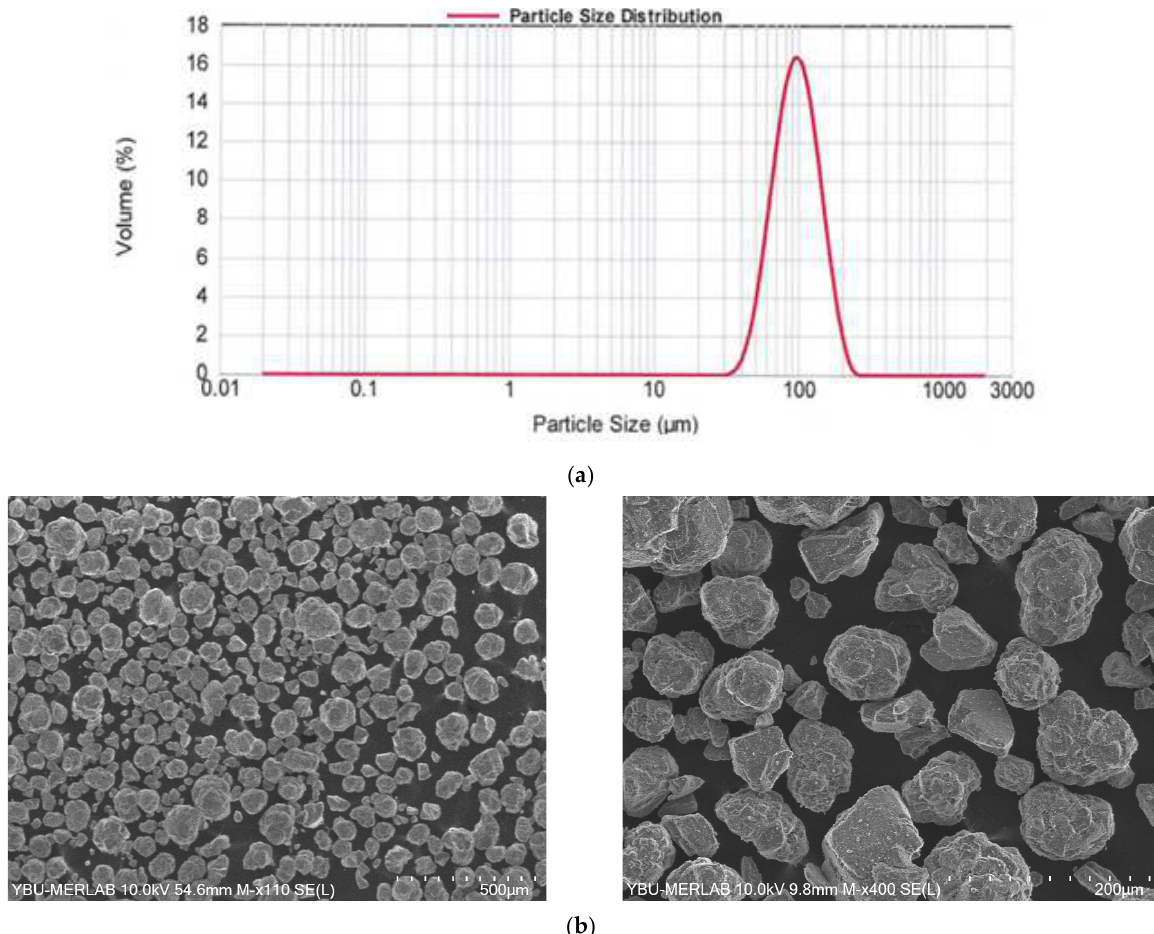
Figure 6. Alumina powder: ( a ) particle size distribution, ( b ) SEM images.